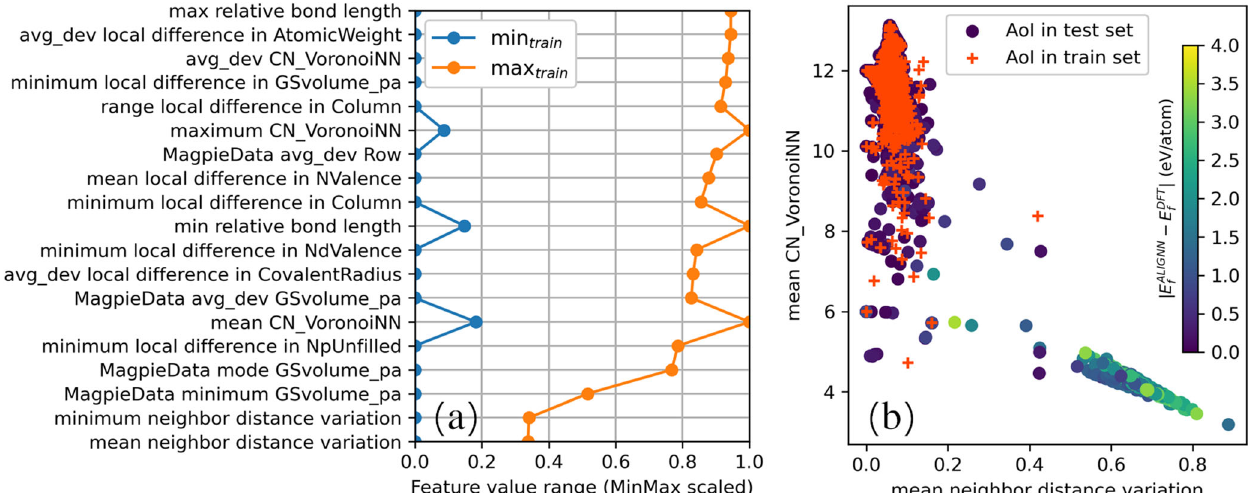
Fig. 7 Distribution of the AoI training and test data. a Feature value range of the training AoI rescaled with respect to that of all the AoI data. b Scatter plot of the AoI training and test data.